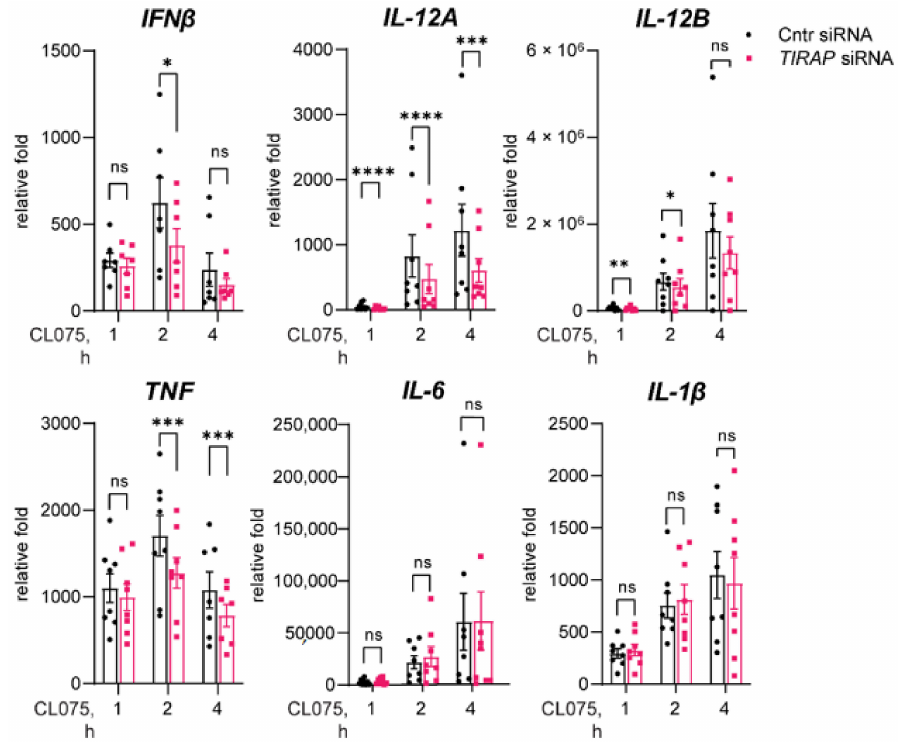
Figure 1. TIRAP silencing in primary human MDMs significantly decreases TLR8-mediated IFN β and IL-12A expression. Macrophages were transfected with control or TIRAP -silencing oligo, followed by stimulation with TLR8 ligand CL075 (2 µ g/mL) for the indicated time. RT-qPCR analysis of cytokine- gene expression after stimulation by CL075 in consecutive experiments with cells from different donors ( n = 6–8). Data for cytokine expression induced by CL075 stimulation were normalized to untreated sample and presented as a mean relative fold change +SEM. Statistical testing was done by 2-way RM-ANOVA including a post-test, as described (* p < 0.05, ** p < 0.01, *** p < 0.001, **** p < 0.0001, and